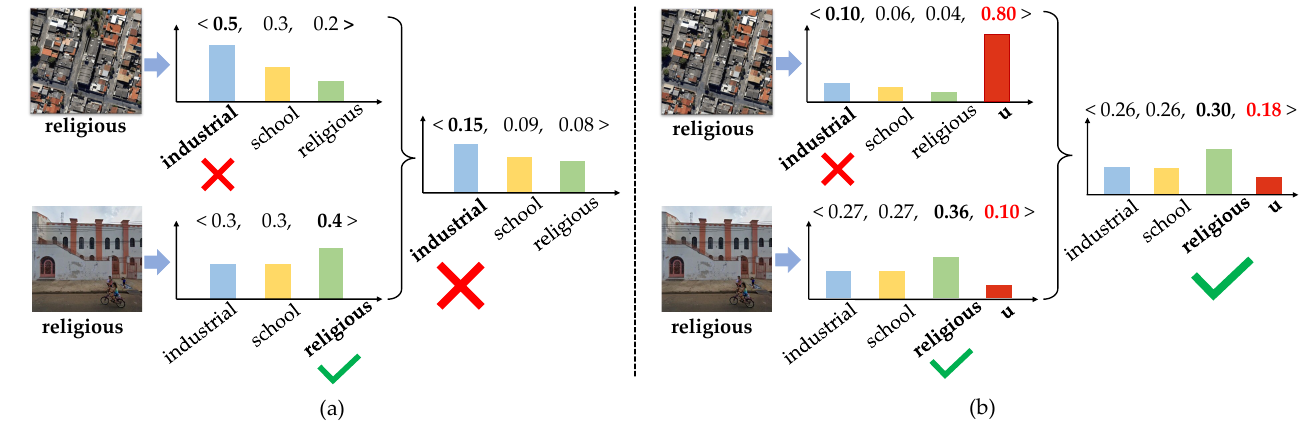
Figure 7. Different predictions are made when using different fusion strategies on aerial-ground dual-view decisions: ( a ) using a multiplication fusion on the softmax outputs of both views; and ( b ) using the proposed evidential fusion on the UQM outputting opinions. All predictions are the class label with the highest score, whether in a single view or after